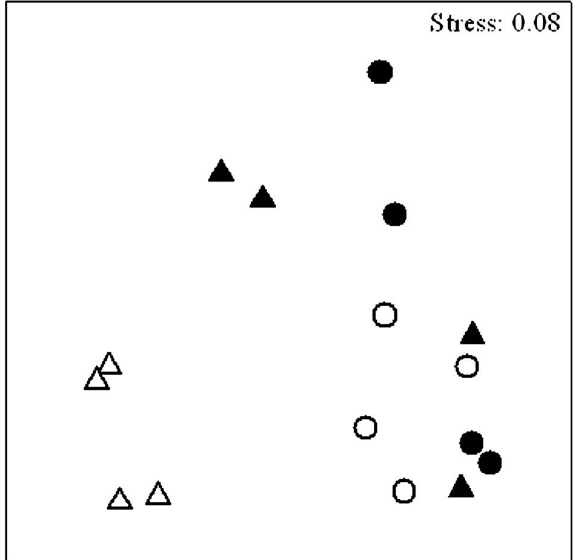
Fig . 3. – Non-metric multidimensional scaling ordination based on Bray-Curtis similarity. White, small islands; black, continental coasts; triangles, -30 m; circles, -40 m.